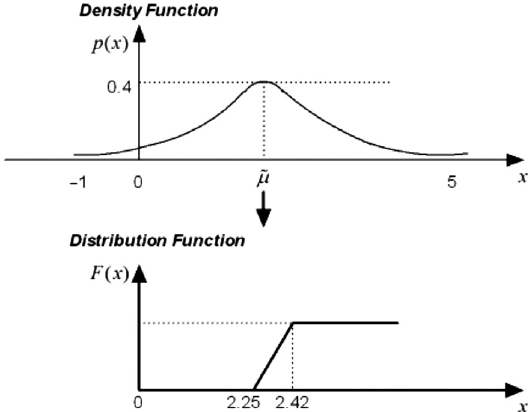
Fig. 3. Flowchart of why the arrival anchor time is a birandom variable